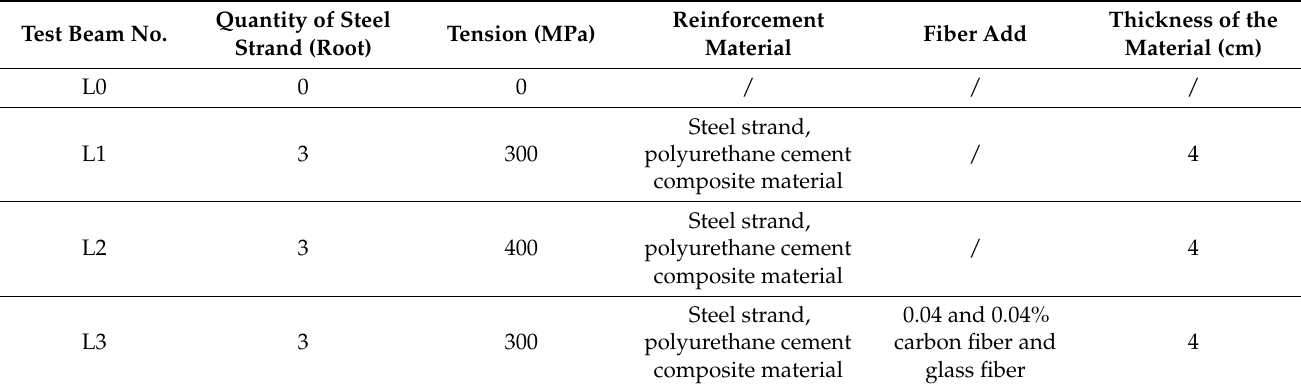
Table 4. Reinforcement scheme of test beams L0–L3.